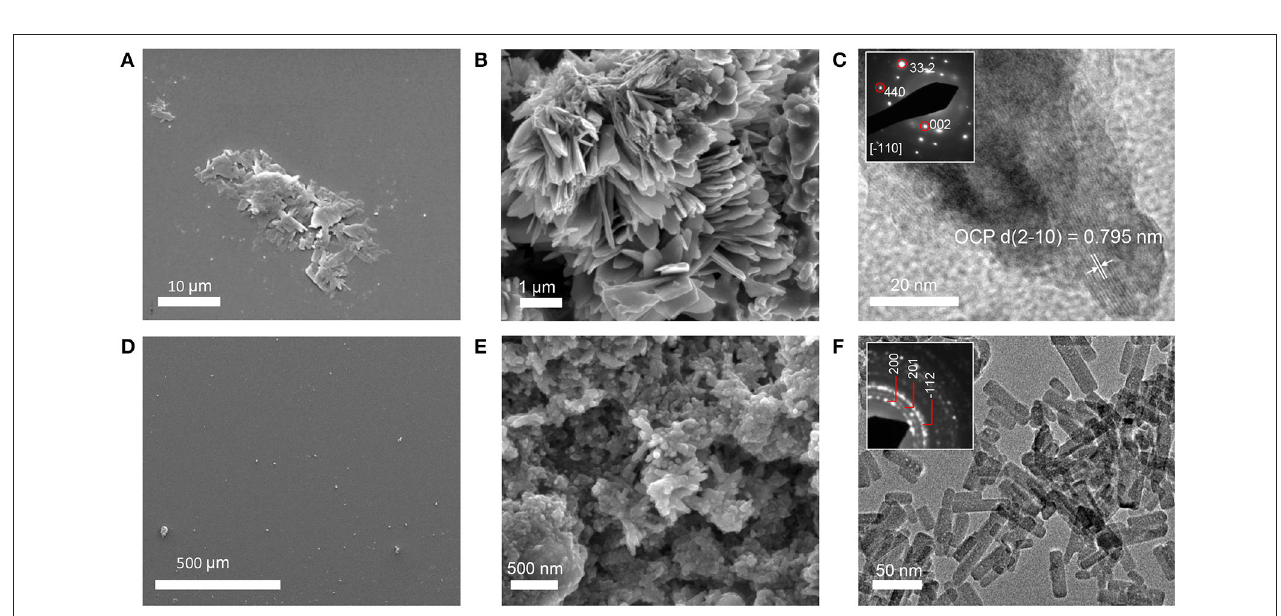
FIGURE 5 | Precipitates formed in control conditions. (A) SE image of 3 h non-coated borosilicate glass. (B) SE image of precipitate formed in solution without STNA15-ELP. (C) High resolution TEM image of precipitate formed in solution with no protein and inset of C showing a typical SAED pattern of the precipitate. (D) SE image of the borosilicate surface after 8 days of incubation in mineralizing solution with no platelets present. (E) SE image of the precipitate in the control solution with no STNA15-ELP at 8 days. (F) TEM image of the precipitate formed in the control solution at 8 days with the inset showing a typical SAED pattern.